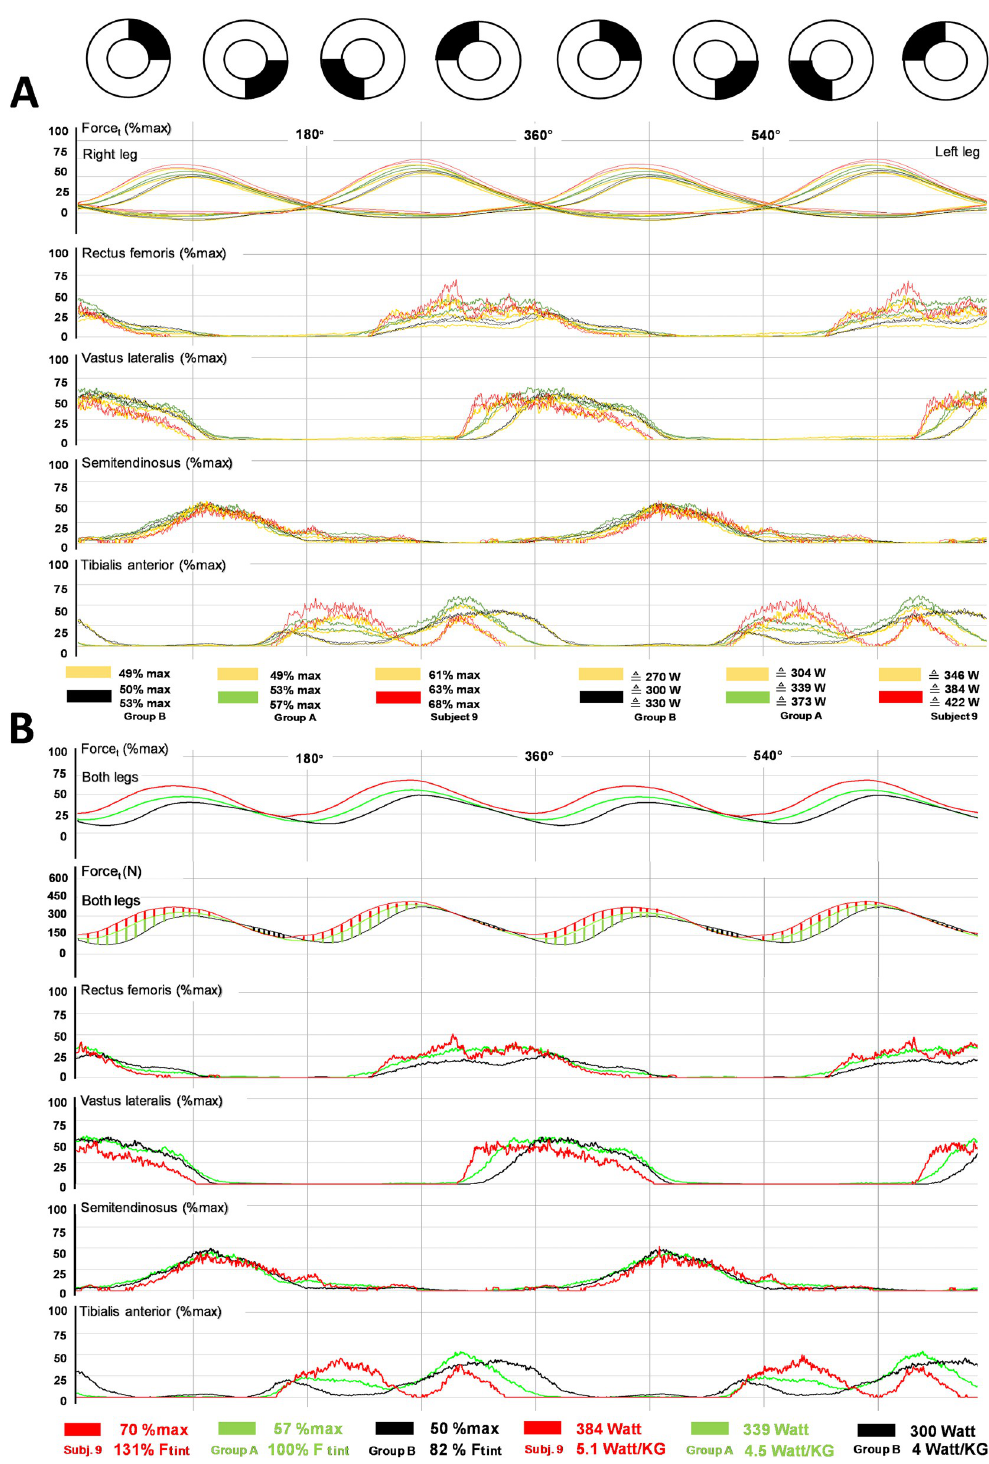
Fig 3. Group comparisons of recruitment patterns and propulsive force around MLSSw in CP- test. ( A) Averaged bi- pedal crank force and EMG data across two pedal cycles (0–720˚) of group A (green), B (black) and subject 9 (red). In CP- tests we recorded an earlier rise of EMG activity in Q3/Q4 and force development in Q1 in athletes with a higher MLSSw/ kgbw. Note the more pronounced increase of RF and VL activity in group A and subject 9 at the transition from MLSSw to MLSSw +10%. (B) Averaged total propulsive force (Ft r+l) and EMG data across two pedal cycles (0–720˚) at the MLSSw